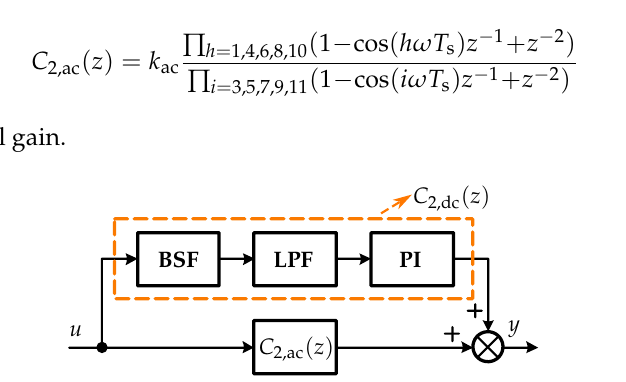
Figure 5. Scheme of the disturbance-mitigation controller C 2 ( z )